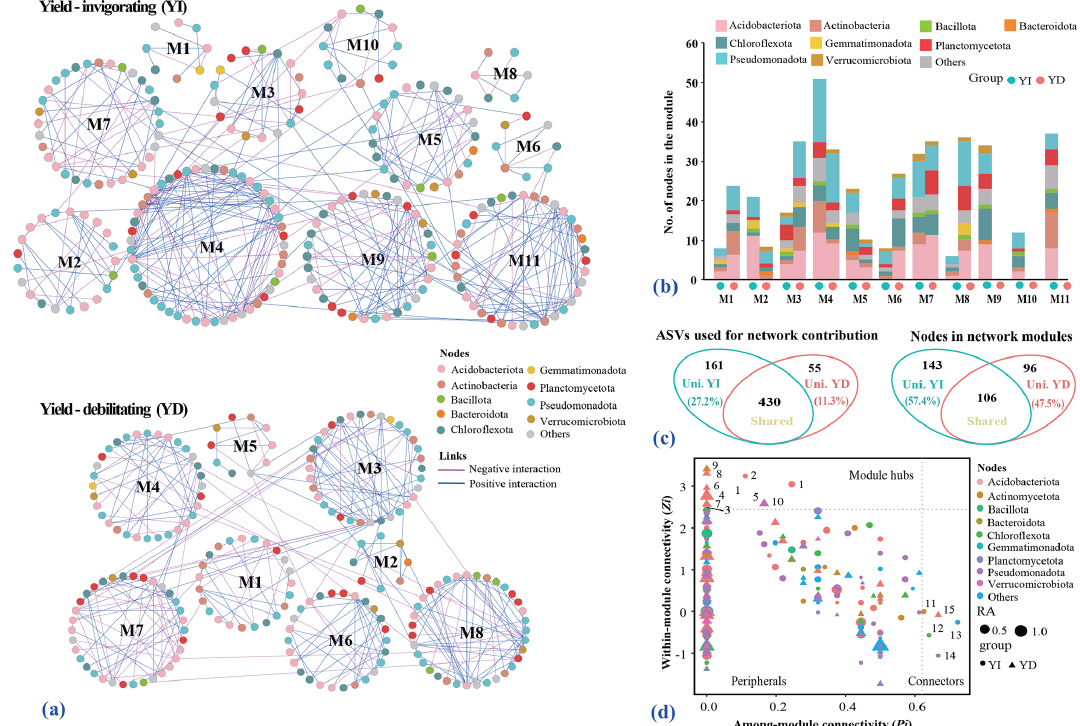
Figure 5. Co-occurrence networks of bacterial communities and identified keystone taxa in distinguishing yield-invigorating (YI) and yield- debilitating (YD) orchards. (a) An overview of microbial phylogenetic molecular ecological networks constructed from YI and YD soils. Blue lines indicate positive correlations in each network, whereas pink lines signify negative correlations. Only modules containing more than five nodes in the networks are displayed in the network and labeled with corresponding letter followed by a number. Circular node colors indicate different bacterial phyla. (b) Stacked figure showing the relative abundance of nodes in each module within each network at the phylum level. (c) Venn plot depicting the unique and shared bacterial ASVs between two networks constructed from YI and YD soils. The left panel is plotted based on the original nodes used in building the network, while the right panel is plotted based on the nodes from modules. Uni. YI and Uni. YD represent unique ASVs in the YI or YD networks, while Shared represent shared ASVs between the YI and YD networks. (d) Z i – P i plot showing the distribution of nodes based on their topological roles. The threshold values of Z i and P i for categorizing OTUs were 2.5 and 0.62, respectively. Node colors indicate different bacterial phyla and node sizes represent the relative abundance in each